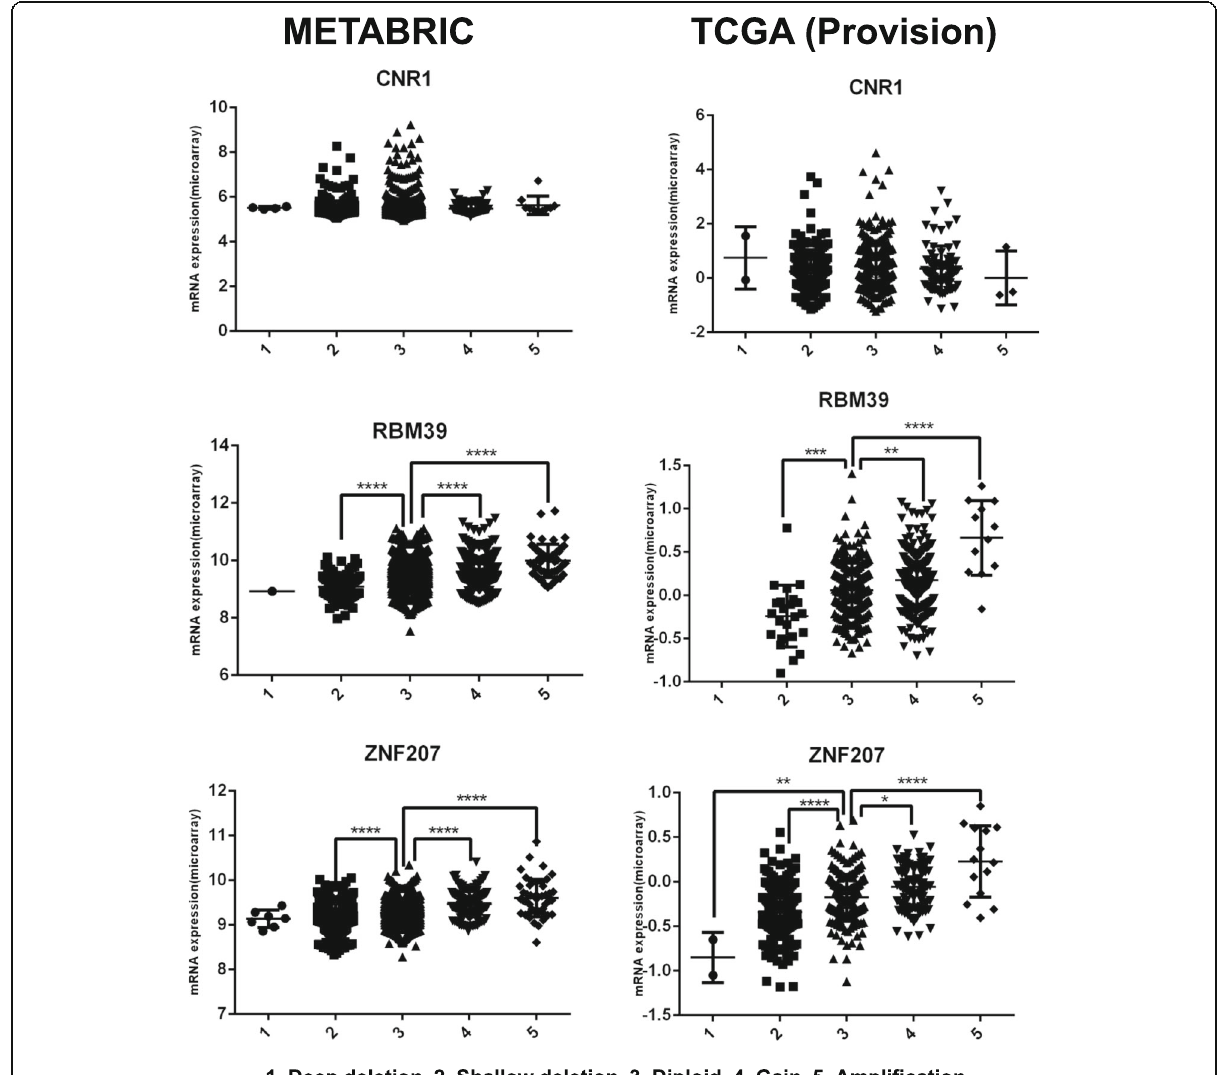
Fig. 6 Copy number alterations for CNR1, RBM39, and ZNF207 across breast cancer patients using a study from METABRIC and TCGA (Provision), analyzed by cBioportal. Statistical analysis was conducted using Student ’ s t test. *or **or ***or ****indicates P < 0.05 or P < 0.01 or P < 0.001 or < 0.0001,